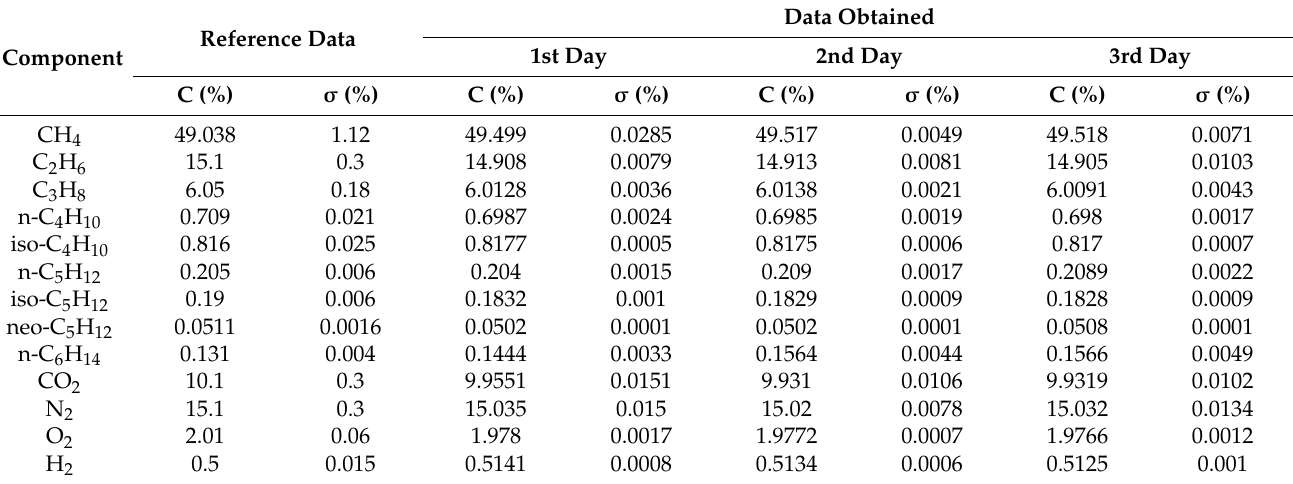
Table 5. Measurement results for sample